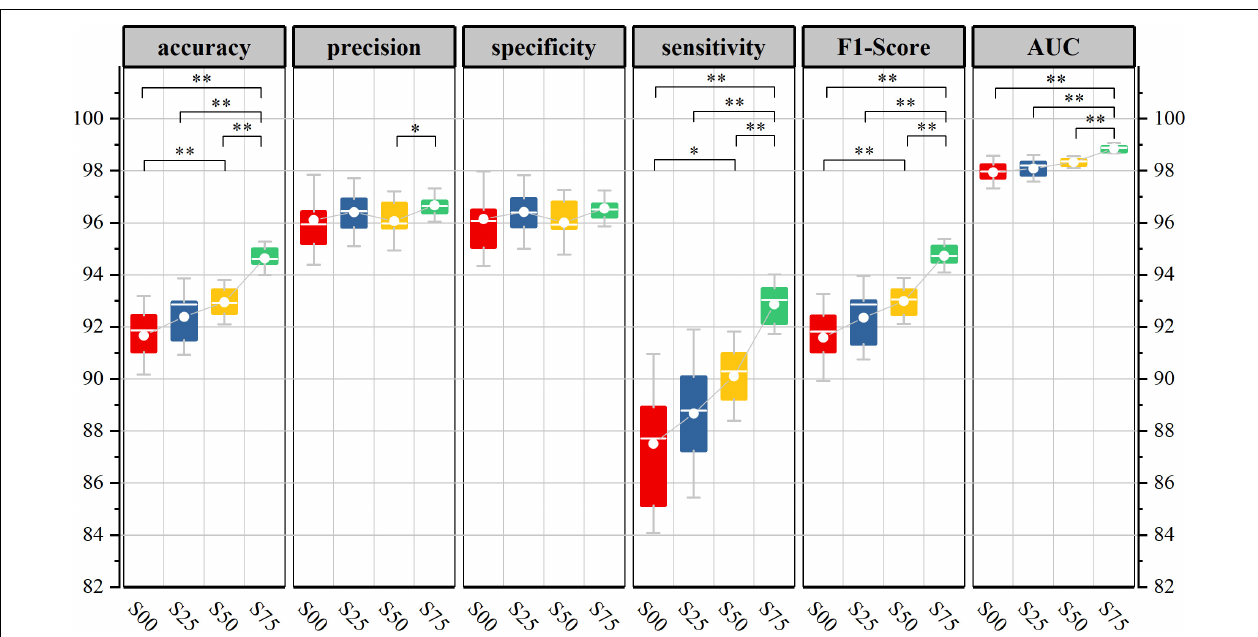
FIGURE 6 | Base-model test performance corresponds to different segmentation overlap rates. (10-fold cross-validation corresponds to model performance metrics in the test set, Kolmogorov-Smirnov test, ∗ p < 0.05, ∗∗ p < 0.01).